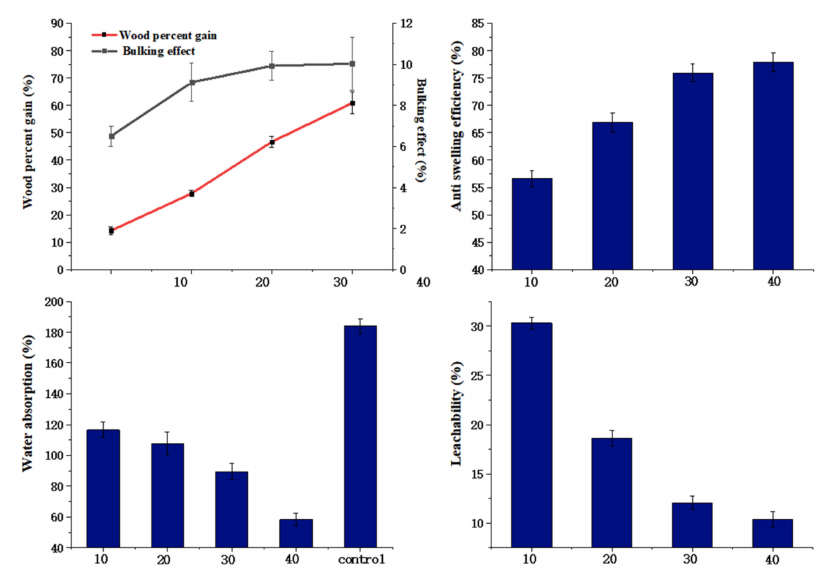
Figure 7. Effects of modifier concentrations on properties of wood.